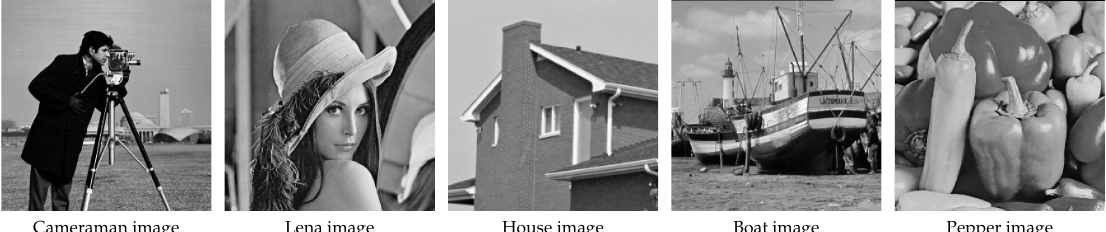
Figure 1. True images for Cameraman, Lena, House, Boat, and Pepper.